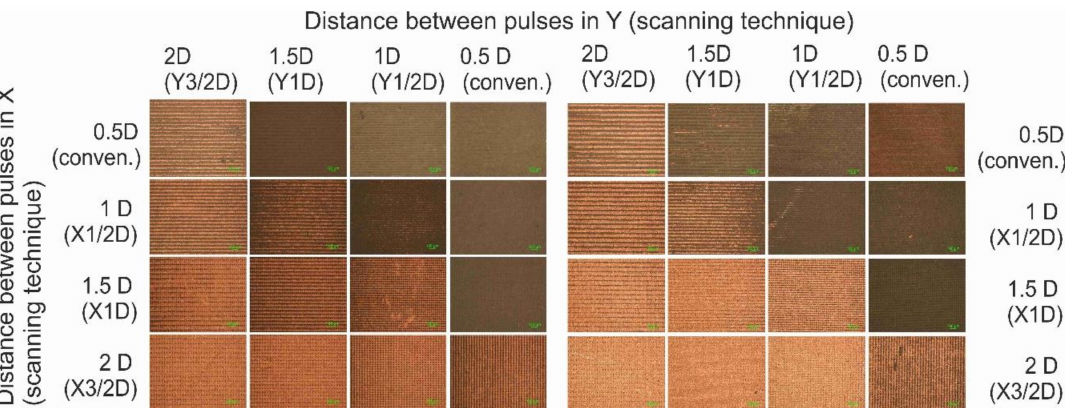
Figure 6. Optical microscope images of surface deposited with copper after electroless plating. The di ff erent types of interlacing pulse writing were applied: X1 / 2D; X1D, X3 / 2D, Y1 / 2D (in lines); Y1 / 2D, Y1D, Y3 / 2D (in columns); and a combination of them at the cross-sections. The average laser power was ( a ) 15 W and ( b ) 25 W at 400 kHz. The scale bar of all images corresponds to 100 µ